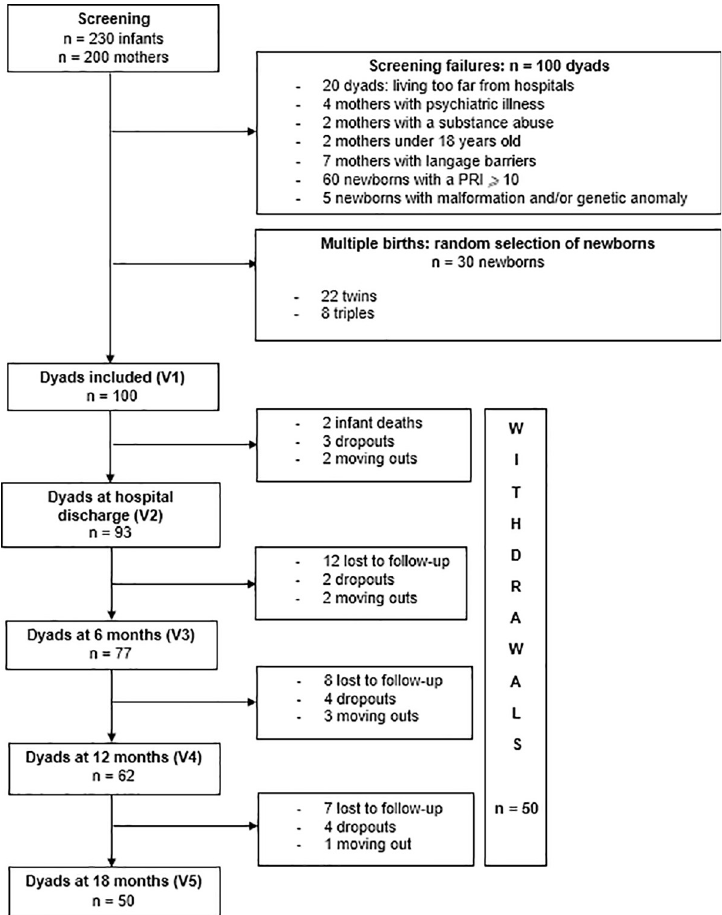
Fig 2. Flowchart of the study. PRI: Perinatal Risk Inventory; V1: assessment at inclusion; V2: assessment at the hospital discharge; V3: assessment 6 months after birth; V4: assessment 12 months after birth; V5: assessment 18 months after